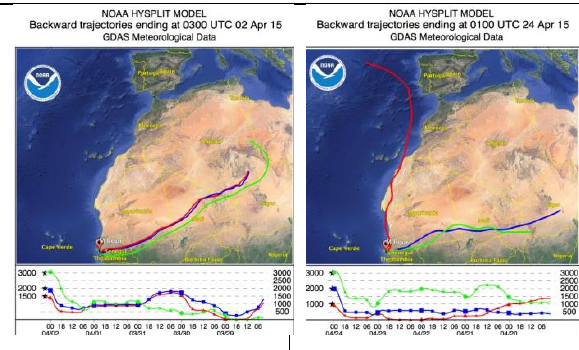
Fig.6. Back trajectory analysis for 2 April (00:00) and 24 April